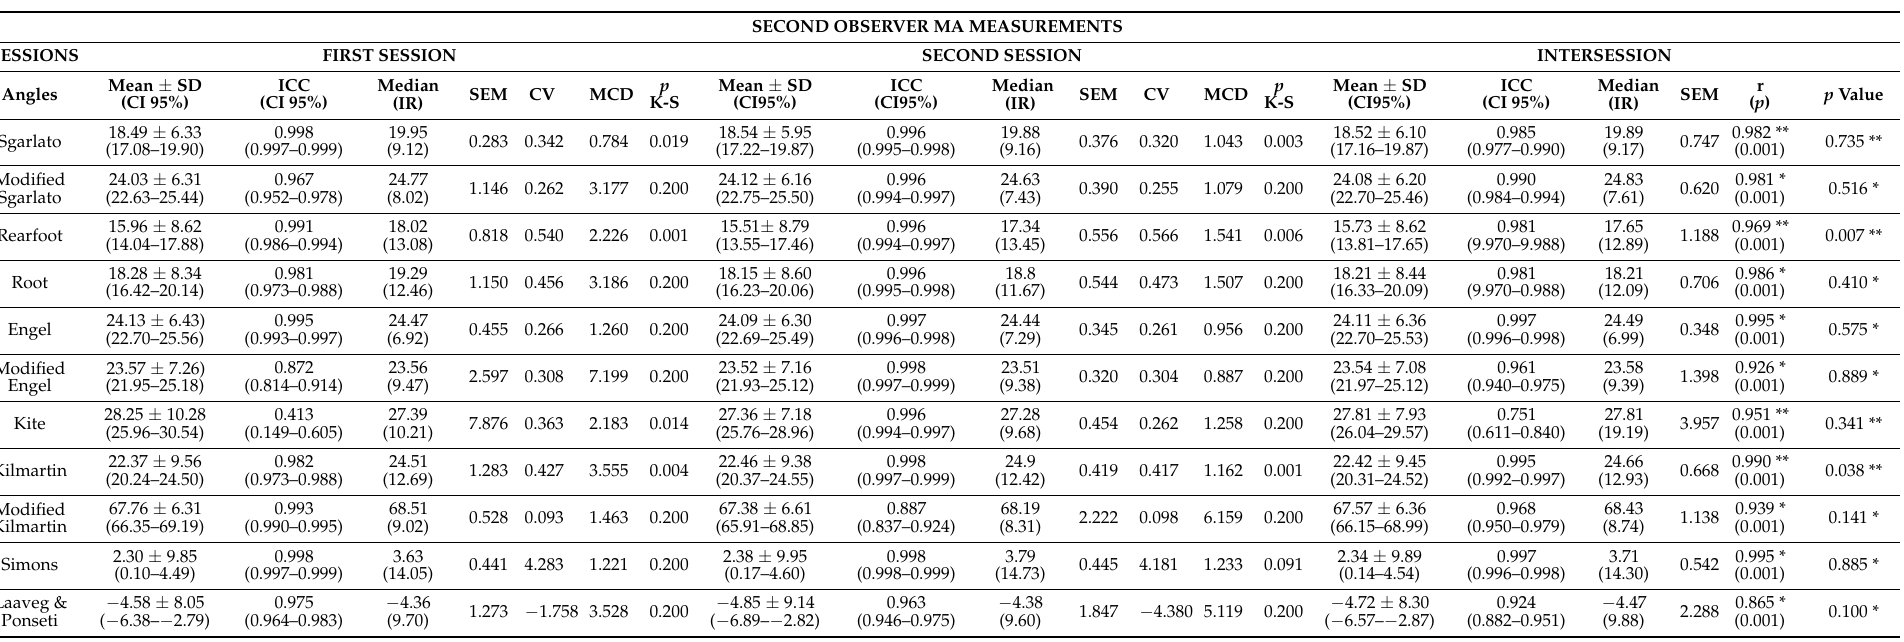
Table 3. Analysis of metatarsus adductus angle measurements between the first and second sessions by the second observer and normalized